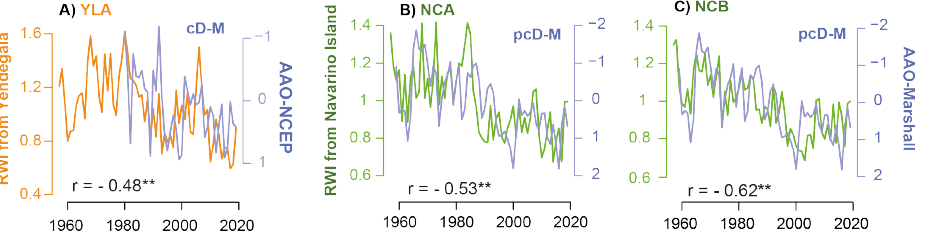
Figure 7. The most significant relationships between the ring-width index (RWI) from SSA and the Antarctic Oscillation (AAO). Significance is indicated by ** = p -value < 0.01. The best com- bination of months for the climate-growth correlations were: cD-M = current December to May, pcD-M = previous and current December to May.